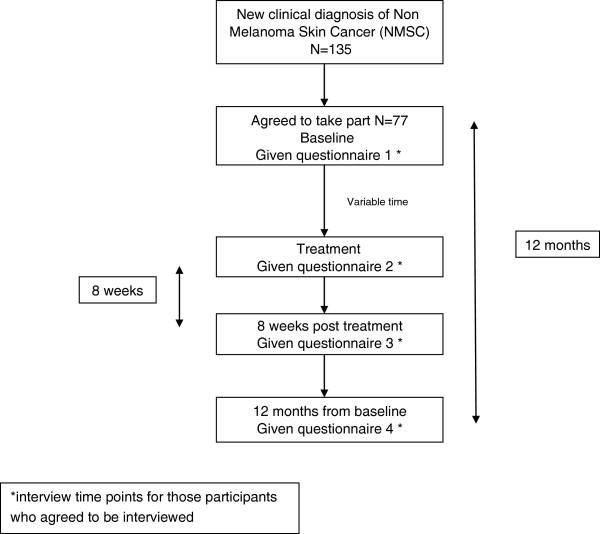
Study flow diagram.